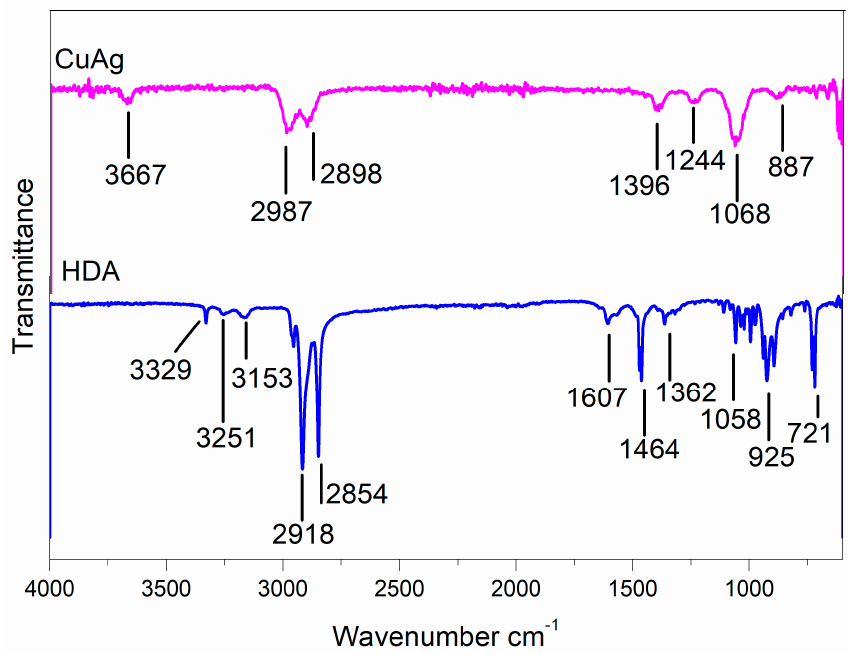
Figure 5. FTIR spectra of copper-silver bimetallic nanostructures and